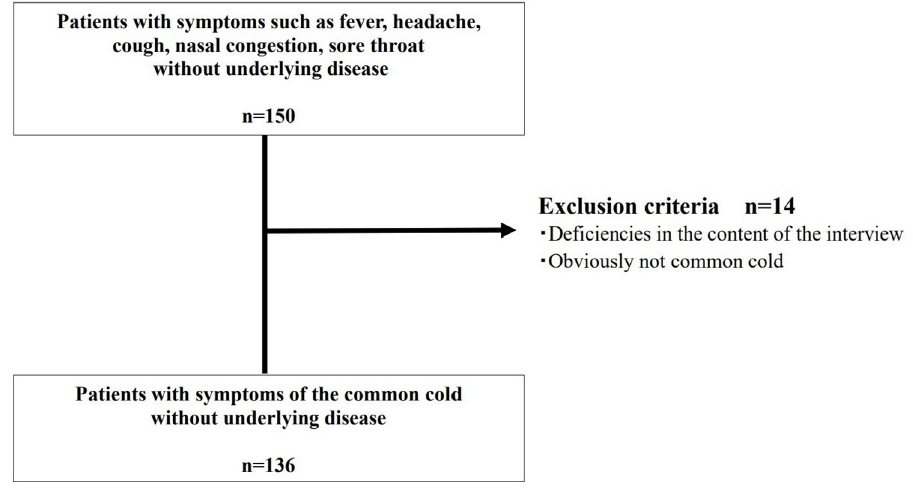
Fig 1. Flowchart of the patient selection